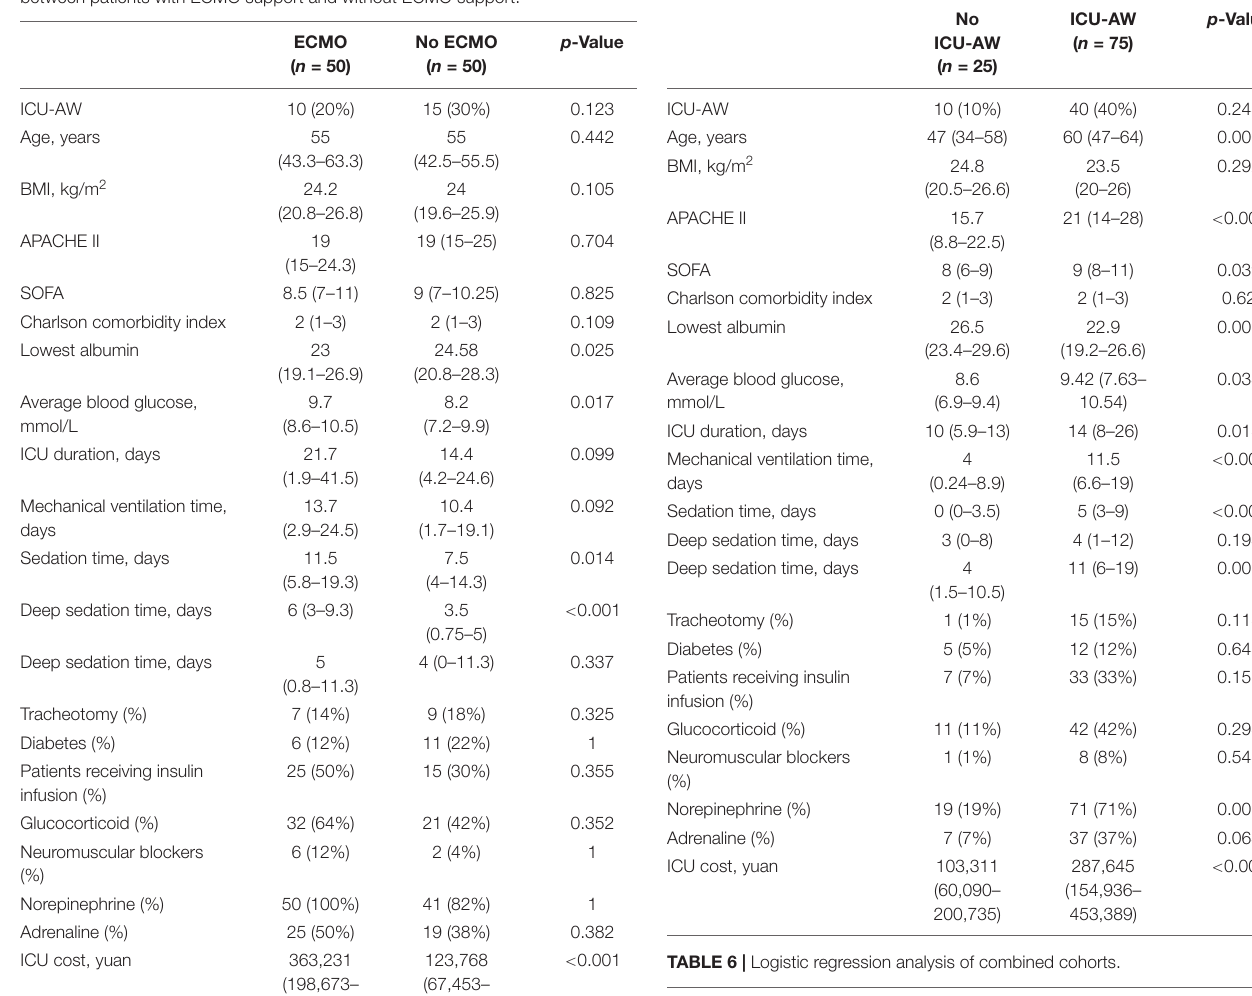
TABLE 5 | Clinical characteristics of combined cohorts.